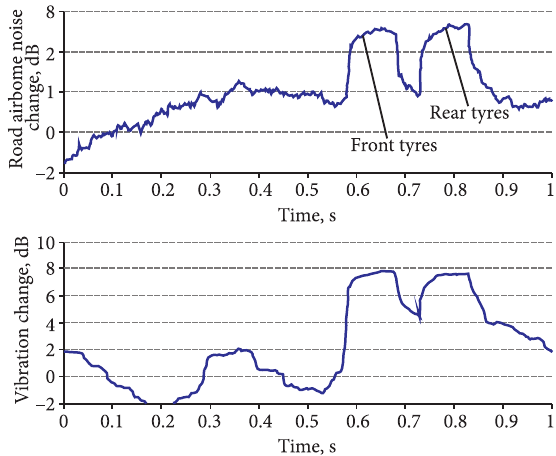
Fig. 10. The raw data captured by Acoustic-Box-in-Vehicle